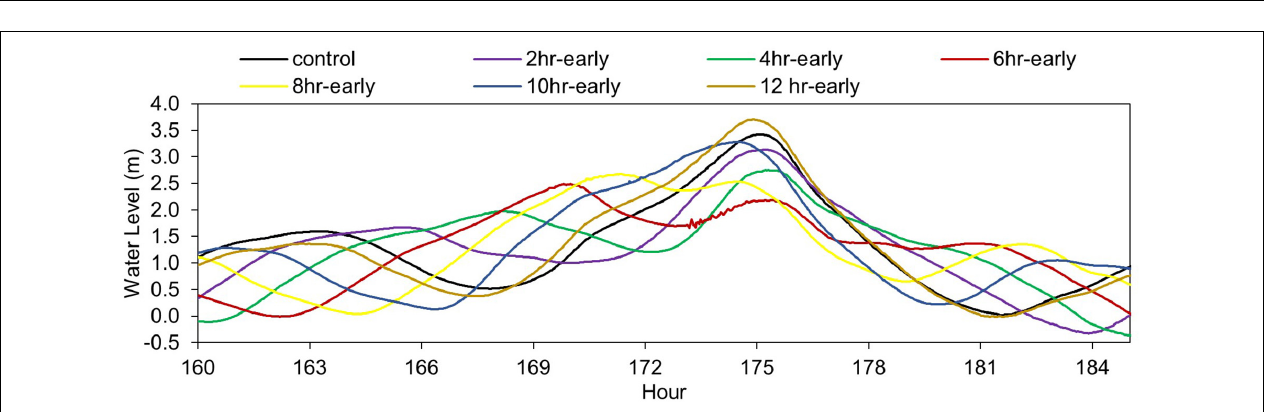
FIGURE 7 | Modeled spatial distribution of maximum flood depth in Manhattan during Hurricane Sandy in (a) the study area and (b) a neighborhood on the east side of Manhattan.